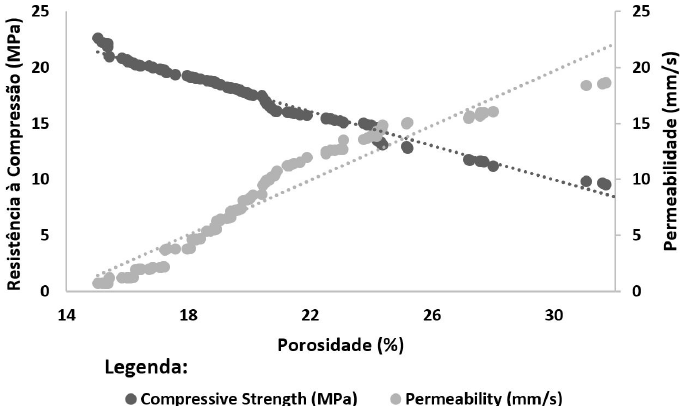
Figure 8 R elationship between Porosity, Compression Resistance and Permeability.